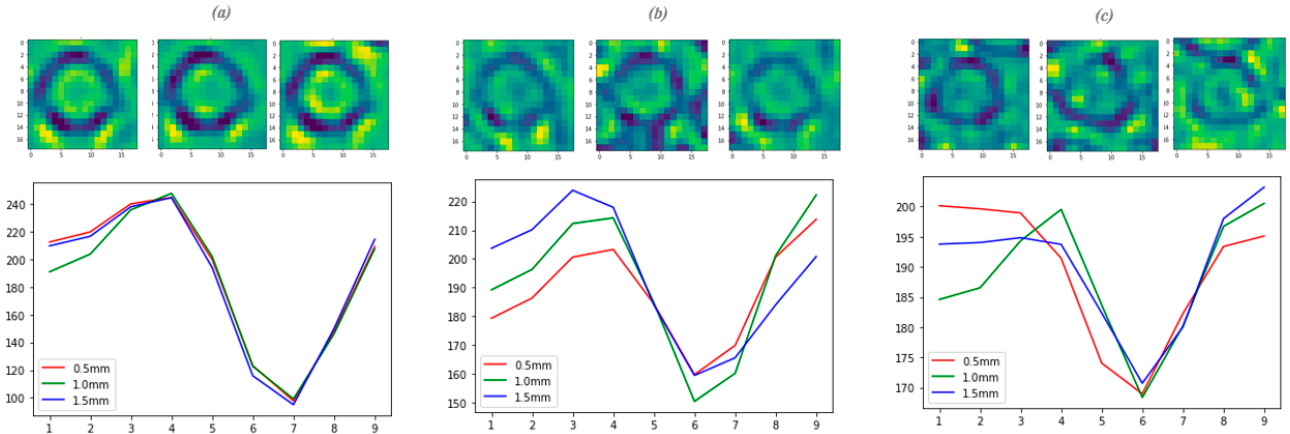
Figure 10. CT images and radial grey level profiles from three fibers with coatings of different thickness at three locations along the length of each fiber: ( a ) coating of high thickness; ( b ) coating of medium thickness; and ( c ) coating of low thickness.